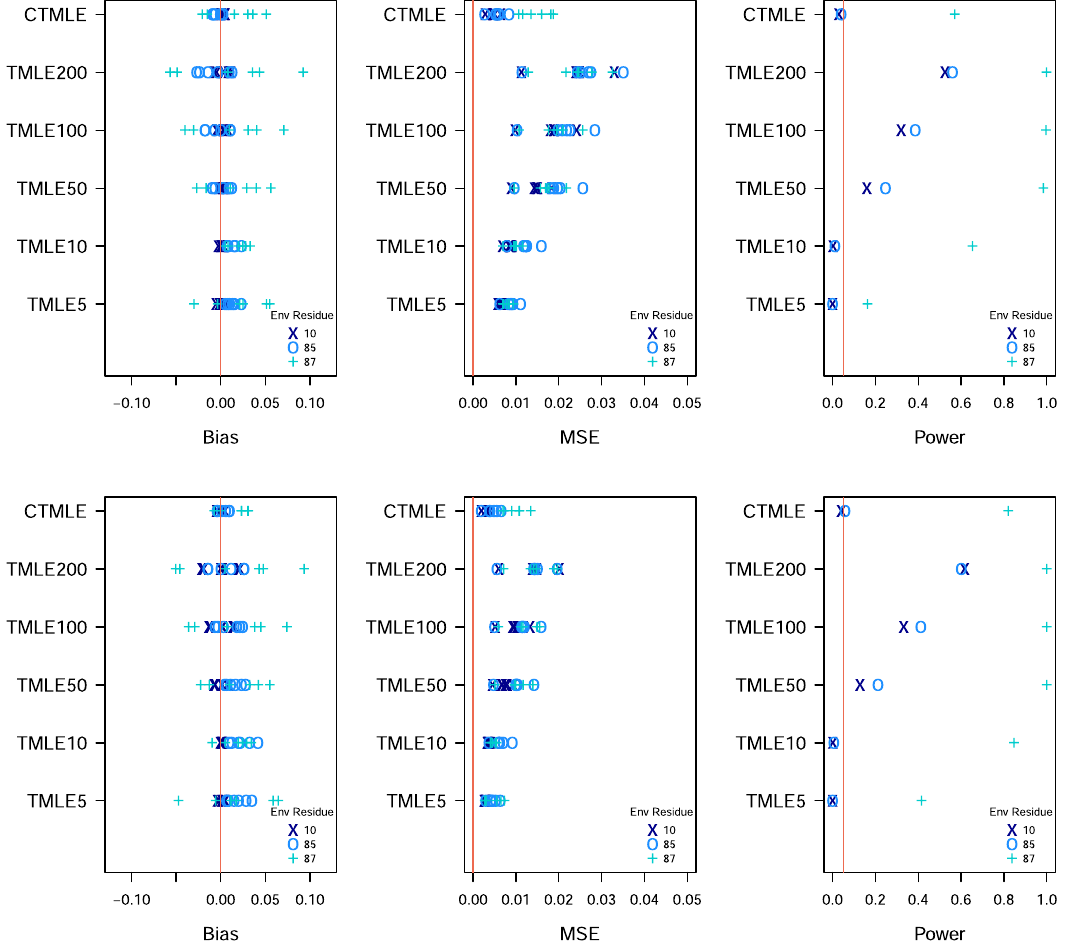
Figure 4: Bias, MSE, type I error rate for null cases and power for true signals. Simulation results with sample size of 500 ( fi rst row ) and 1,000 ( second row ) were visualized for two null cases and one true signal. Compared with standard TMLE approach using all 200 features, CTMLE largely reduced bias and MSE, especially for the non - signals. it also maintained a relatively high power with better controlled type I error as good as the best model among the fi ve proposed TMLE scenarios. As sample size increases, the power for CTMLE increased from 0.57 to